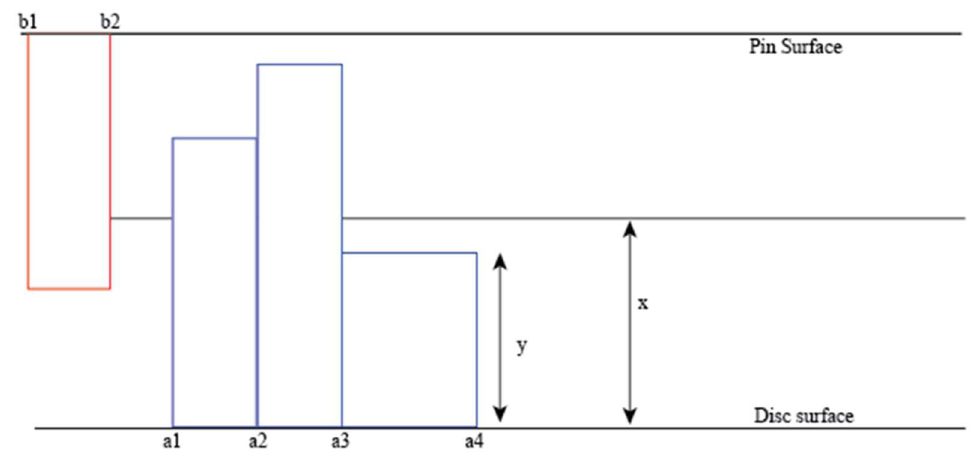
Figure 1. Conditions of